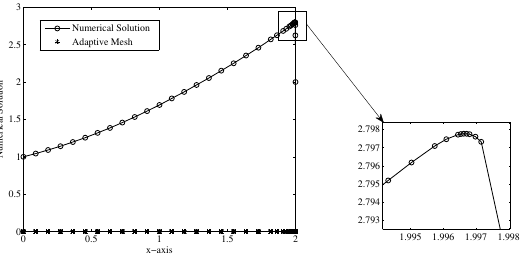
Figure 2. Numerical solution for Example 2 with ε = 2 − 8 , N = 23 (initially)